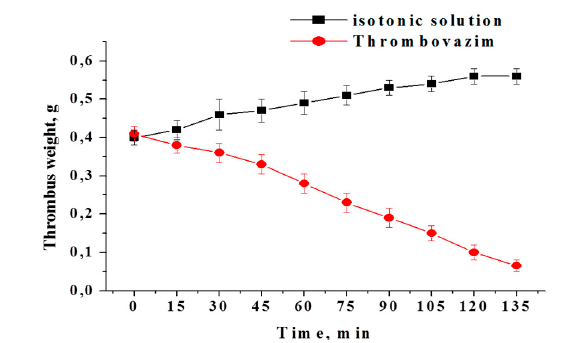
Figure 2. Dissolution of a 24-h thrombus.